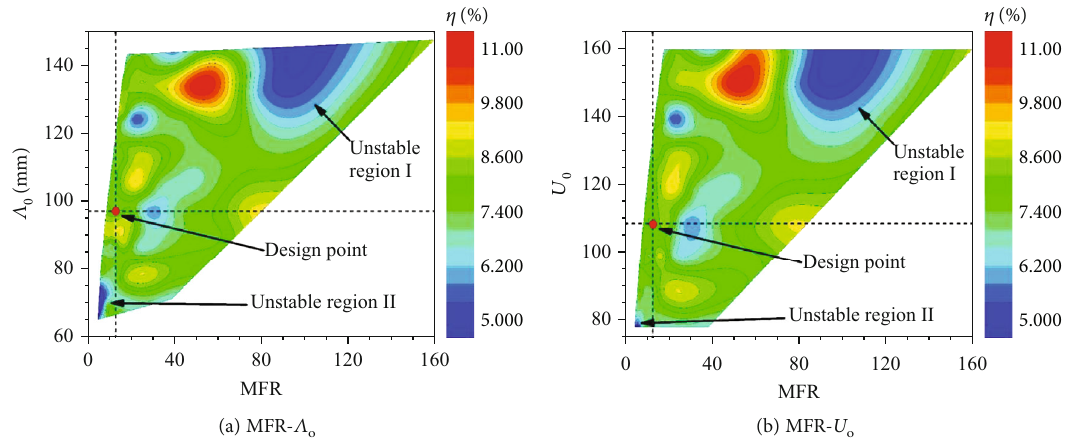
MFR − U o and (b) o under self-excited